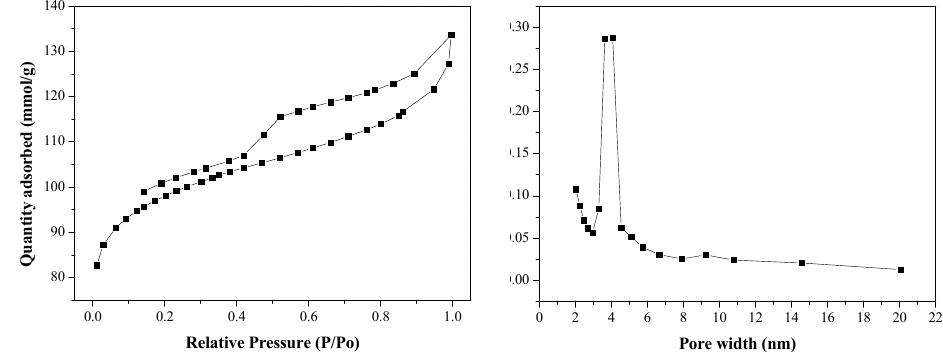
Figure 1. N 2 adsorption-desorption isotherms ( left ) and pore size distribution ( right ) of DM-BC.